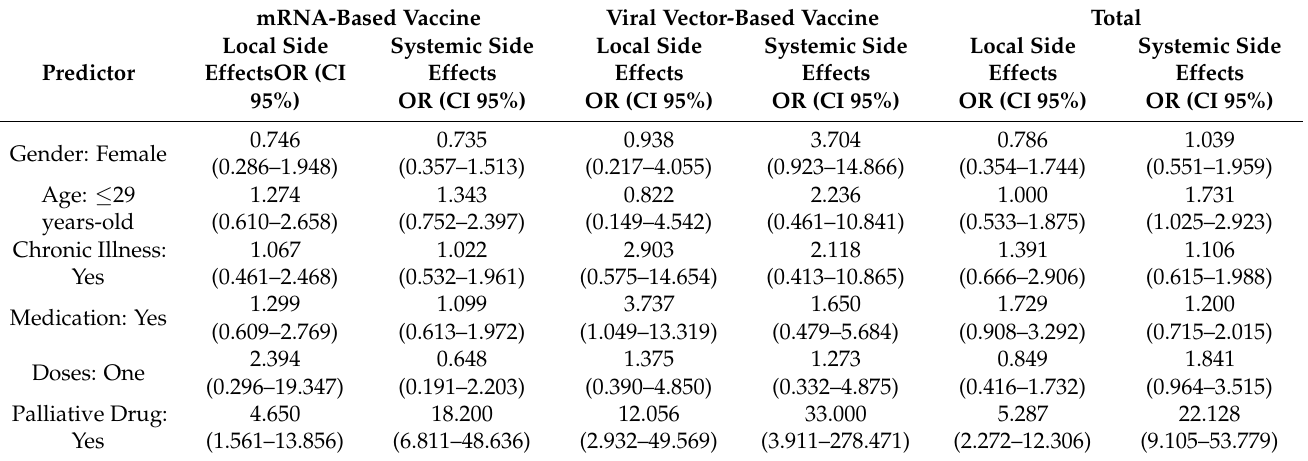
Table 10. Predictors of COVID-19 vaccines SRAEs reported by Polish healthcare workers.